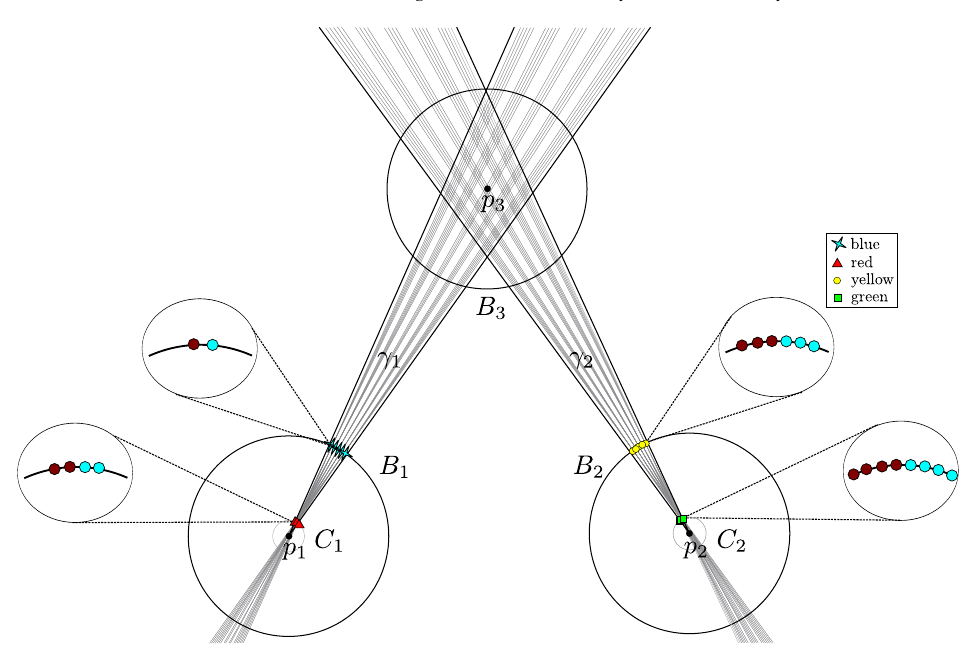
Fig. 3: A bi-colored set with Ω( n 4 ) different colored radial